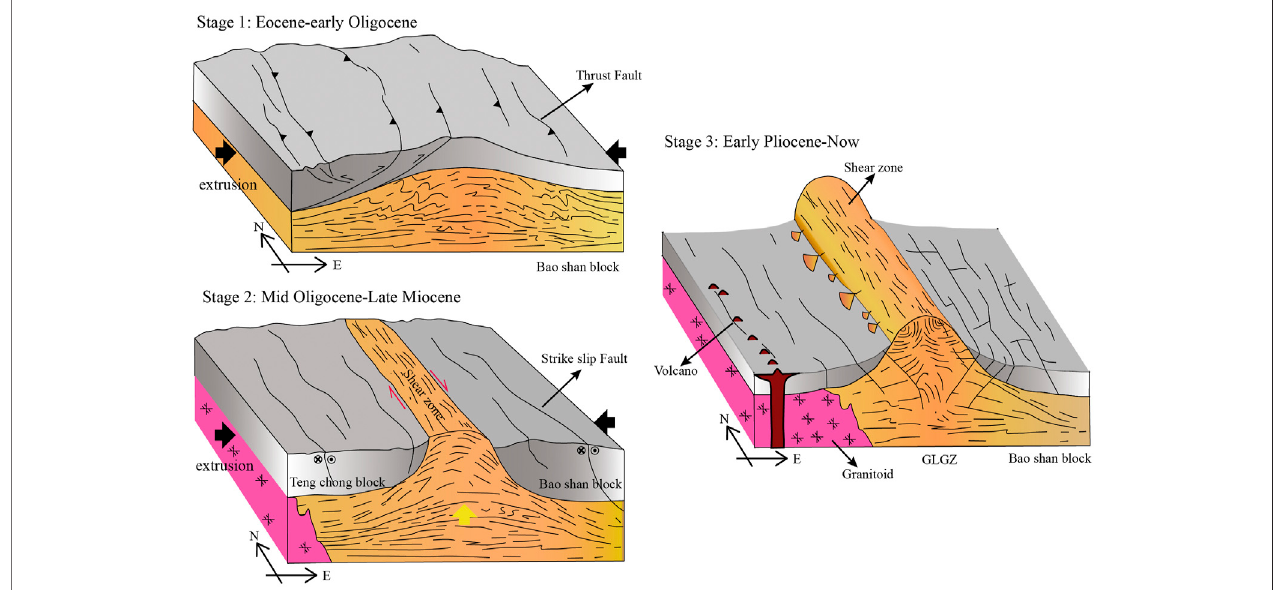
FIGURE 8 | A simpli fi ed conceptual model illustrating the tectonic evolution and uplift and exhumation process of the Gaoligong shear zone (GLGSZ). During the Eocene – Early Oligocene, the crust might have been shortened and thickened in the southeastern margin of the Qinghai – Tibet Plateau, resulting in the weakening of the rheology of the middle and lower crust. Right-lateral ductile shear occurred from the Middle Oligocene to Late Miocene. During this time, the GLGSZ acted as a channel for vertical extrusion of low-viscosity crustal materials in the deep. Since the early Pleistocene, the Gaoligong Mountain has been further uplifted and exposed, the middle and upper crust has been dominated by brittle deformation, the plates have been staggered by active faults, and magmatic activity has been enhanced.